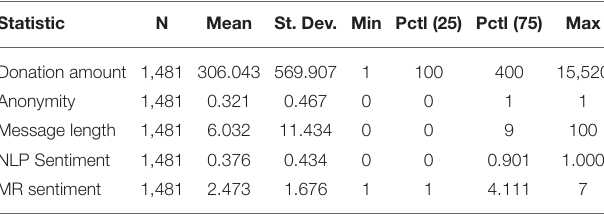
TABLE 2 | Summary statistics. TABLE 3 | The regression results of donation